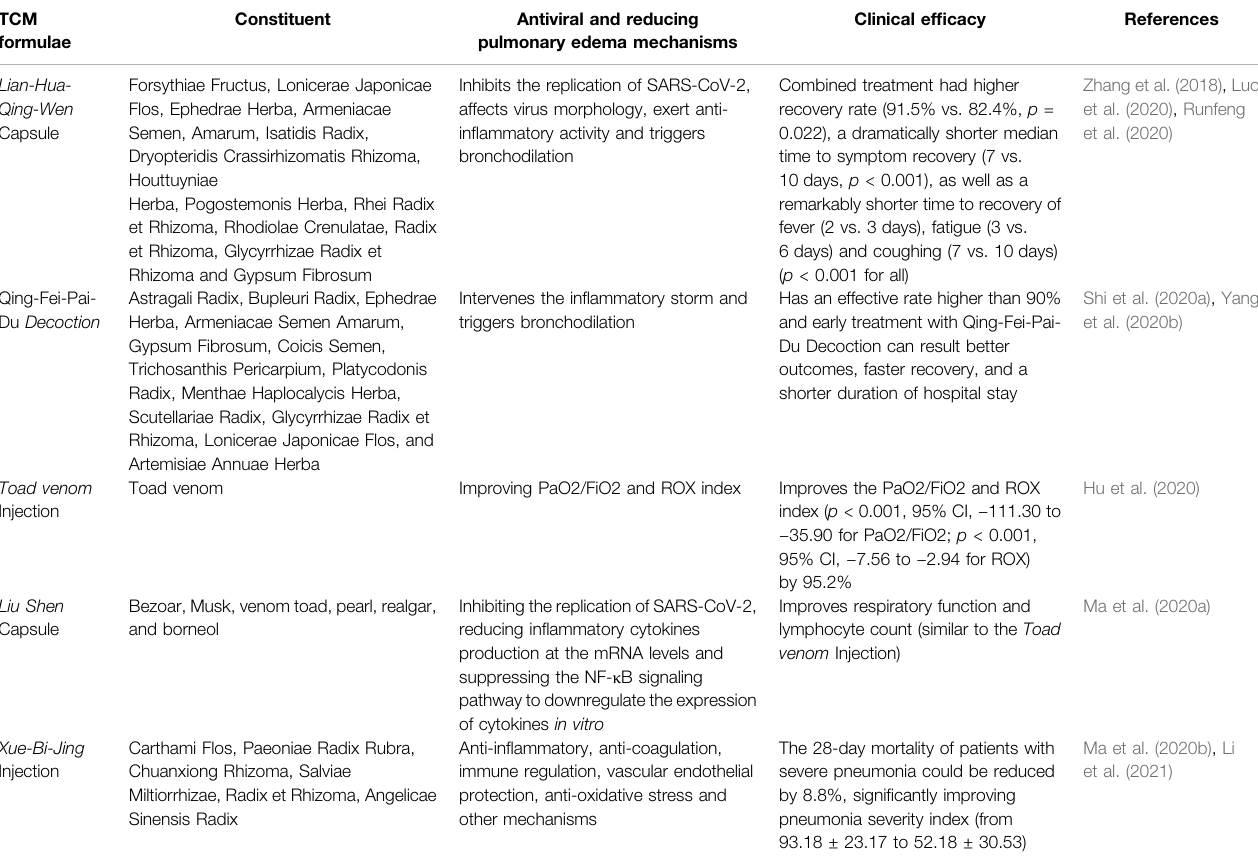
TABLE 3 | Summary of potential TCM formulae against